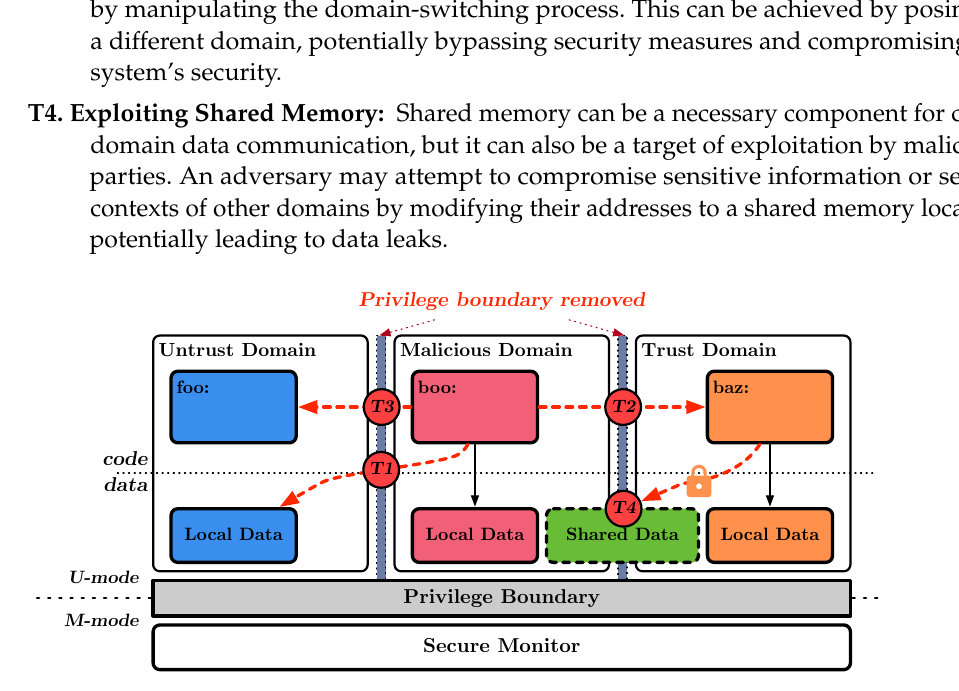
Figure 1. Threats in unprivileged